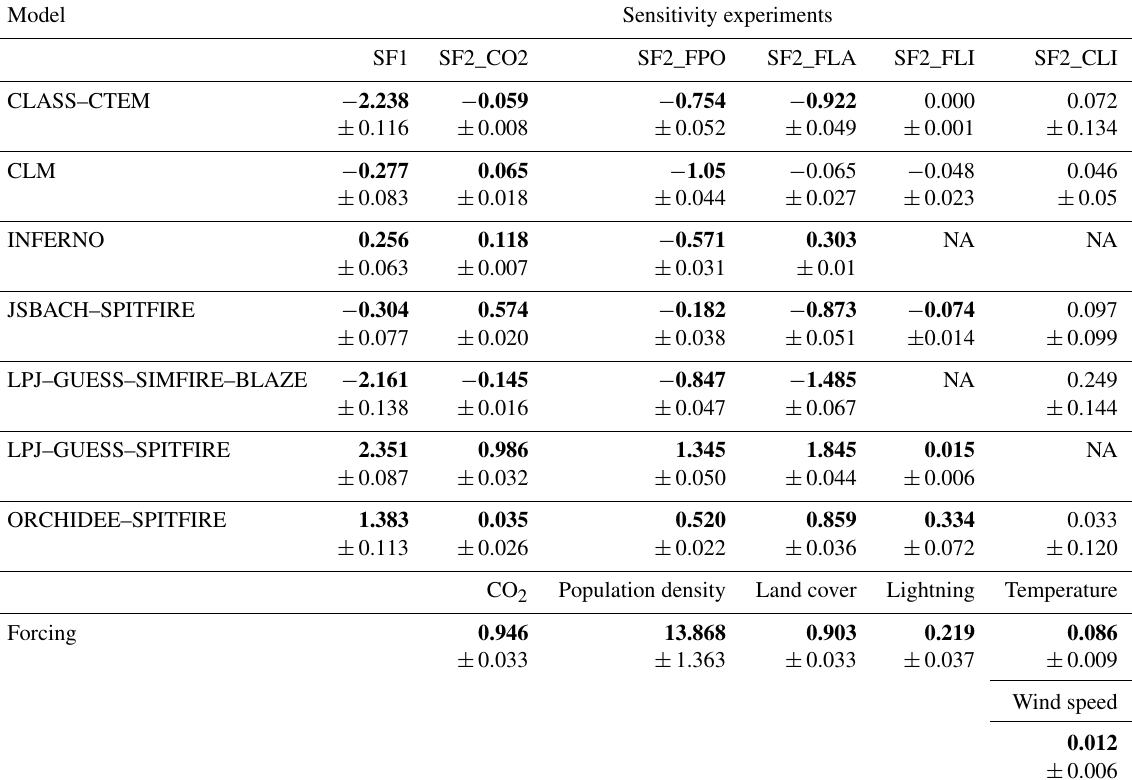
Table 4. Trends (slope and standard error of a linear regression, megahectare per year, Mhayr − 1 ) in annual global burned area for the years 1921–2013 for the baseline experiment SF1 and absolute difference time series of annual burned area. The trends for the forcing datasets are based on the relative difference between the transient forcing and year 1920 values for SF2_CO2, SF2_FPO and SF2_FLA and are based on the relative difference between the transient and the recycled forcing for SF2_FLI and SF2_FCL for the years 1921–2013 (%) (see Table 1). Bold values indicate significance based on a Mann–Kendall test ( p value < 0.05). Experiments that are not available for specific models are indicated with NA.